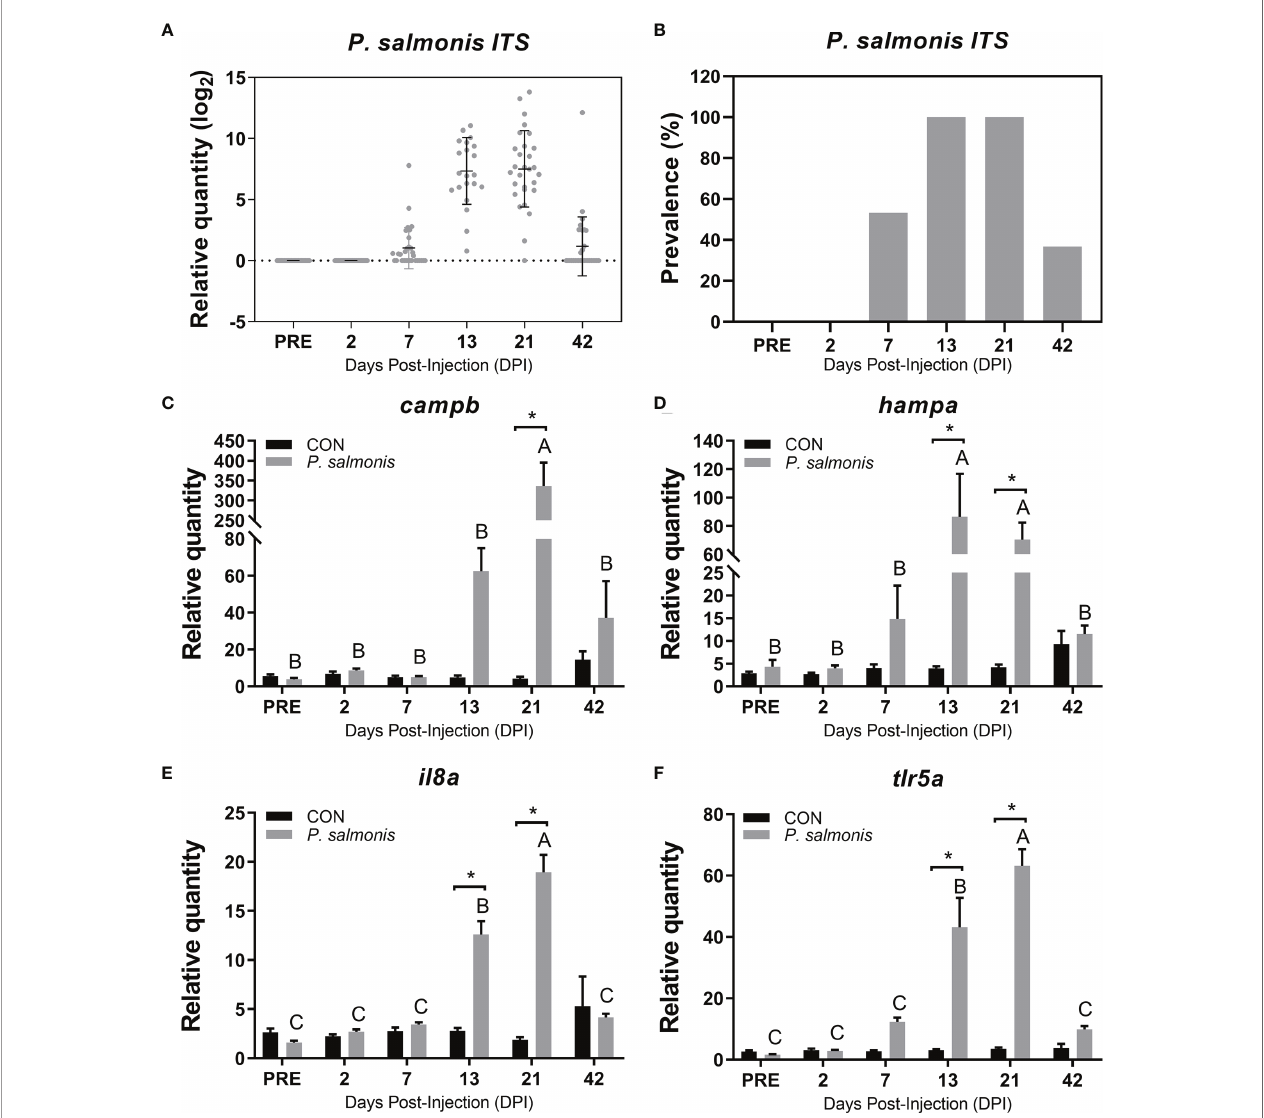
FIGURE 2 | Detection of P. salmonis transcript and evaluation of candidate immune biomarkers in the head kidney of Atlantic salmon across different time points. (A) Transcript levels (i.e. relative quantity) of P. salmonis 16S-23S ribosomal RNA internal transcribed spacer ( ITS ) in the head kidney of Atlantic salmon injected with the same dose of bacterial inoculum, as determined by TaqMan assays across all sampling time points. (B) The relative prevalence of P. salmonis positive (i.e. detection of P. salmonis ITS ) in fi sh that were injected with bacterial inoculum. (C – F) qPCR analysis of host immune biomarkers ( campb , hampa , il8a , tlr5a ) in both control (CON) and P. salmonis injected fi sh. Data are presented as mean ± SE. An asterisk indicates a signi fi cant difference between time-matched P. salmonis injected and control groups. Different letters represent the signi fi cant differences within an injection group over time. All data presented in the fi gure are provided in Supplemental Table S2